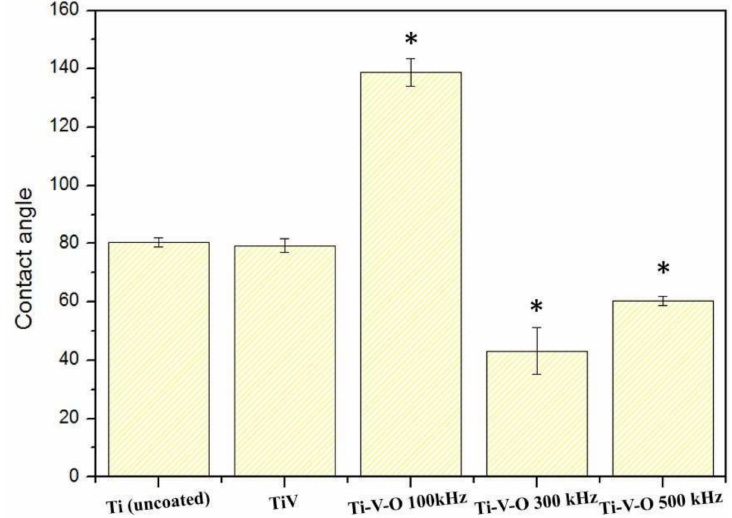
Figure 9. Water contact angle of the Ti (uncoated) sample, Ti-V-coated sample, and Ti-V-O sample subjected to LSTO. * Significantly different from the control group—uncoated Ti plate ( p <